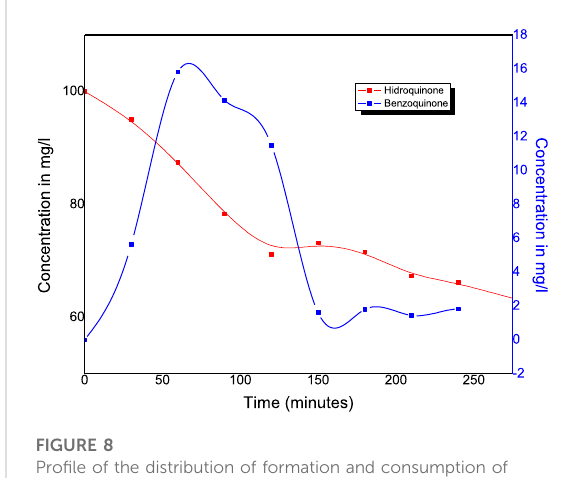
FIGURE 8 Pro fi le of the distribution of formation and consumption